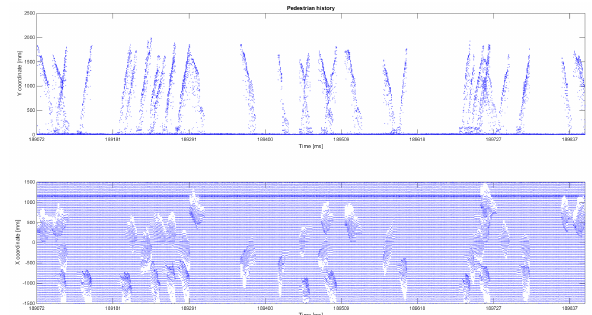
Figure 2. Time series for orthogonal coordinates of the profile scanner: the pedestrians direction (upper diagram) and their pres- ence (lower diagram)